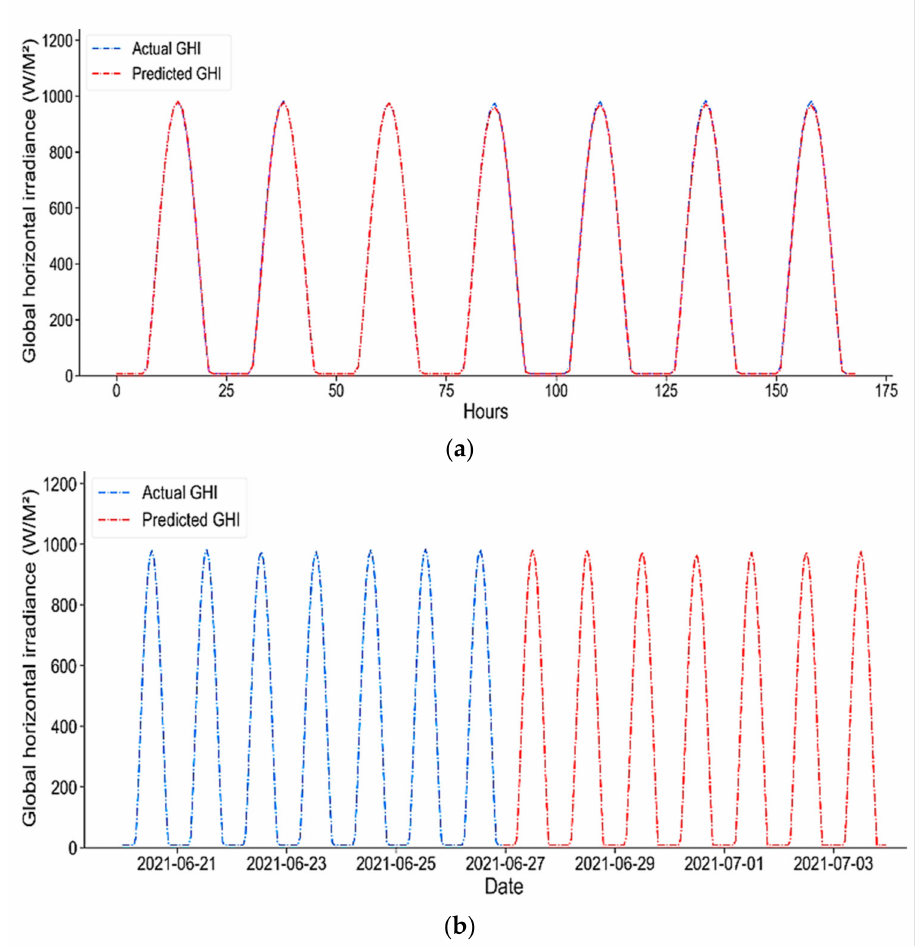
Figure 18. ( a ) The real and predicted values of GHI, which show the fit and performance of the BI-LSTM model; and ( b ) the GHI’s predicted future values for the next 169 h.